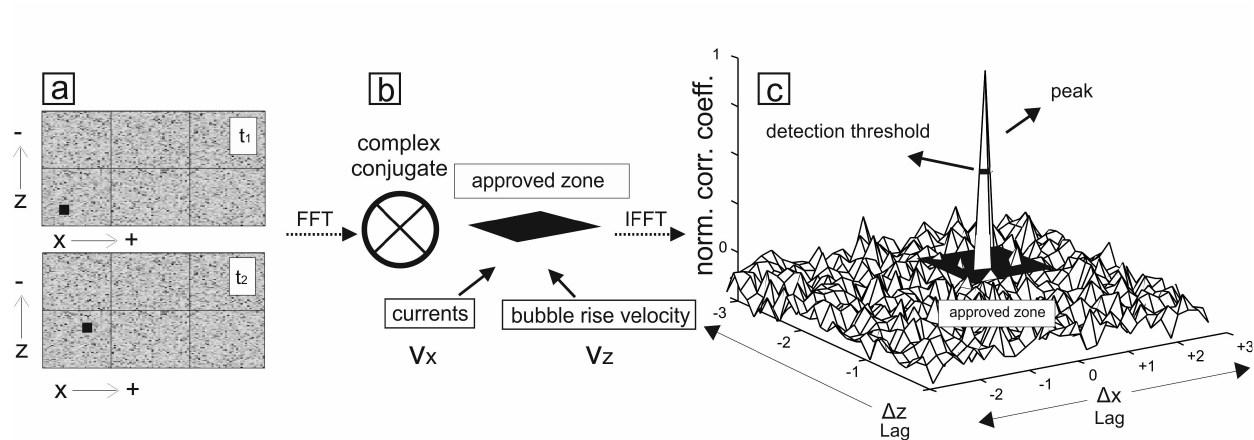
Fig. 1. Schematic diagram illustrating the workflow of a proposed detection algorithm showing (a) synthetic echo-images with a solitary “seed” (black rectangle) moving into +x and − z direction over time period 1 t, (b) cross-correlation in the frequency domain and the definition of the “approved zone” controlled by horizontal currents v x and rise velocity v z , and (c) bubble displacement visible as a Dirac delta peak within the “approved zone” in a 2-D